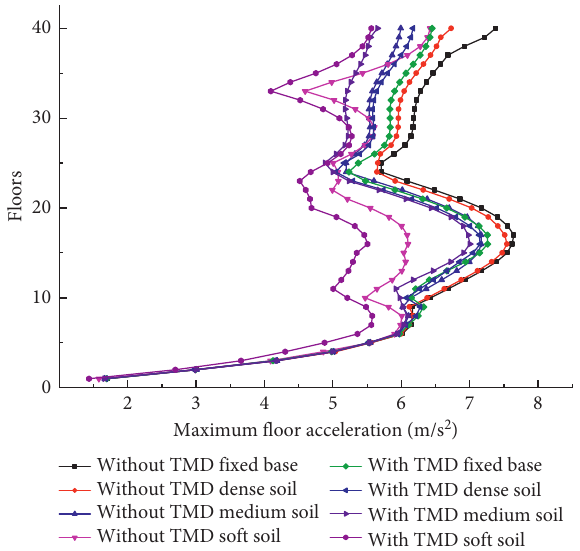
Figure 12: Tangshan earthquake peak acceleration comparison chart.